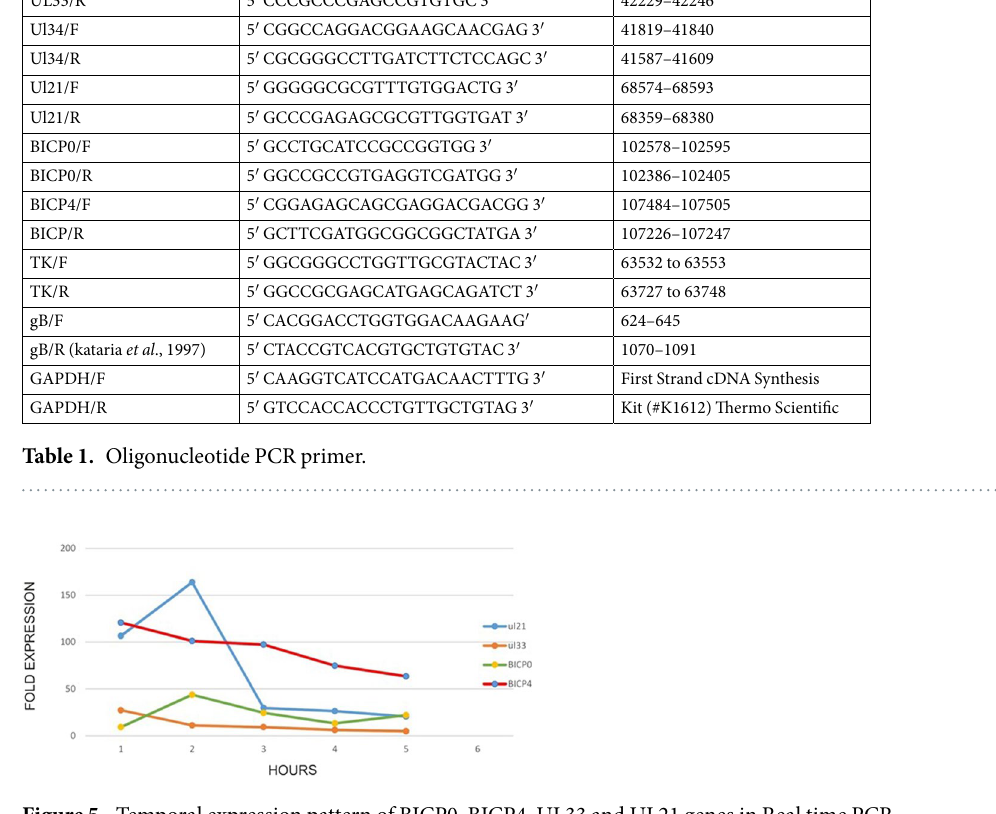
Figure 5. Temporal expression pattern of BICP0, BICP4, UL33 and UL21 genes in Real time PCR.